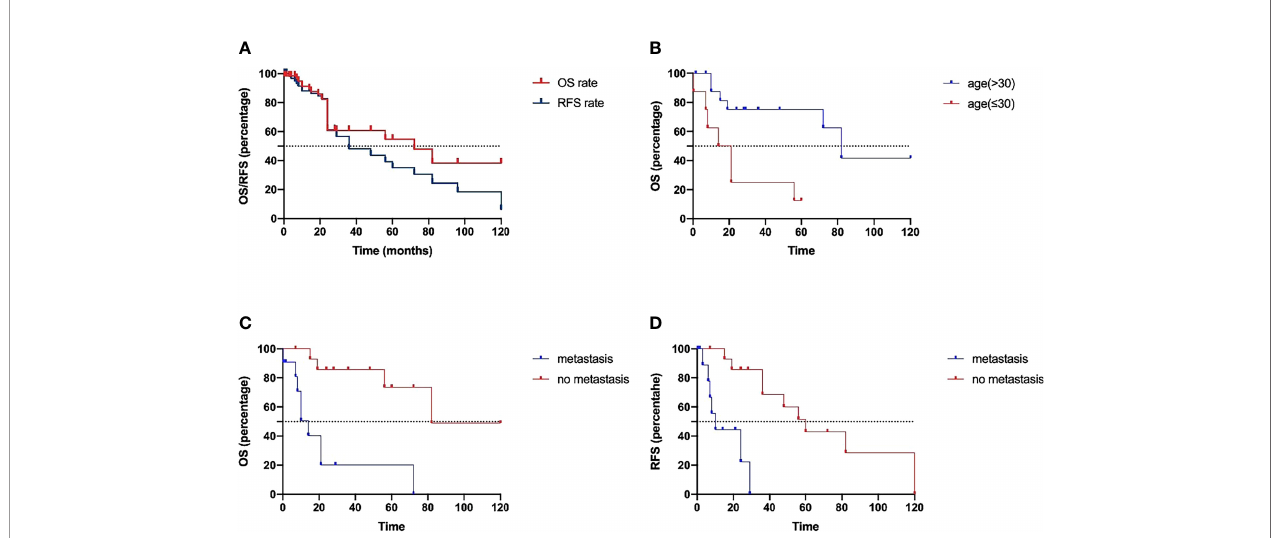
FIGURE 2 | (A) The Kaplan – Meier curves of OS and RFS. The log-rank tests indicated that age at diagnosis (B) and presence or absence of metastasis (C) were the potential risk factors for OS, and presence or absence of metastasis (D) was also the potential risk factor for